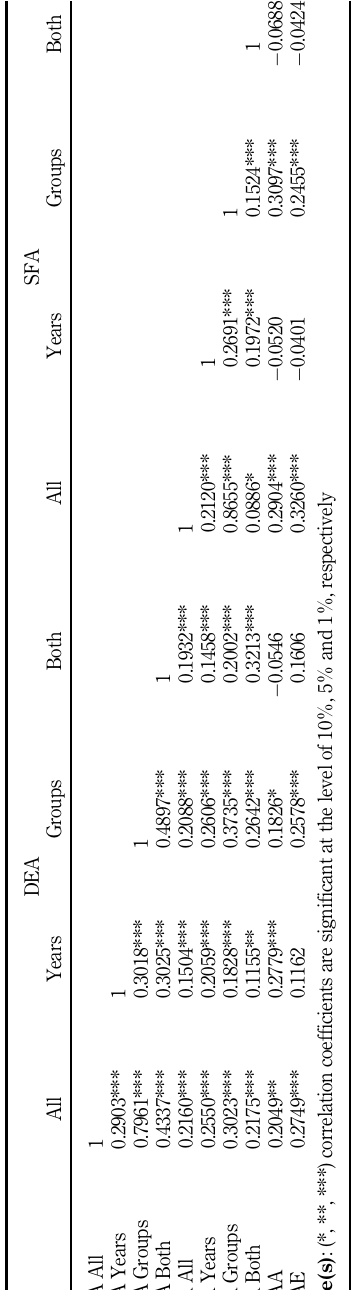
Table 5. The consistency of efficiency ranks across